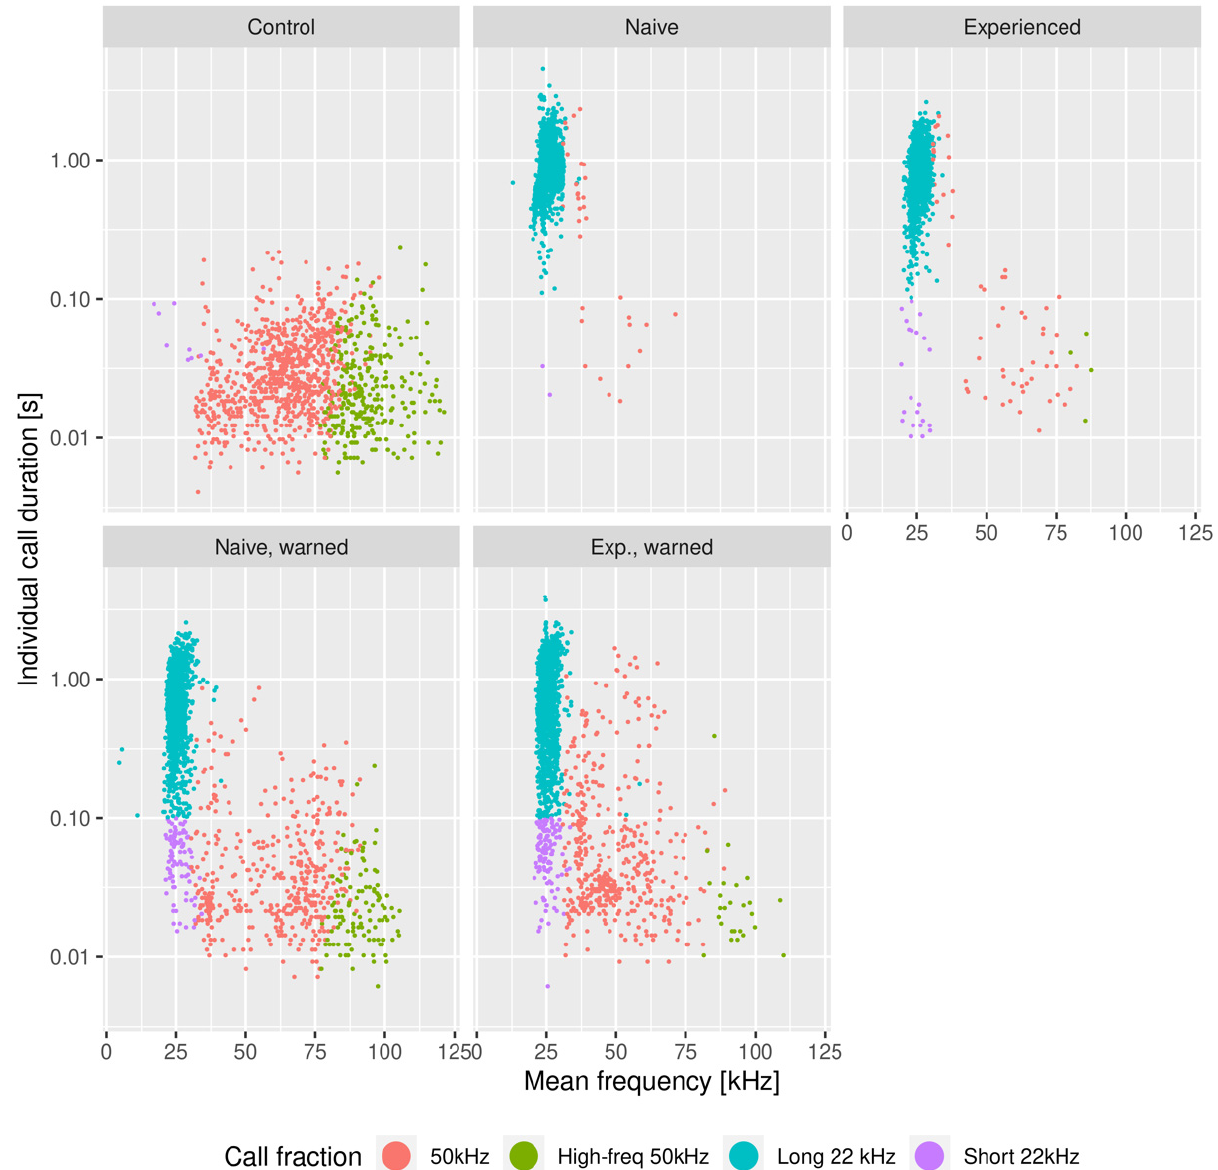
Figure 4. Scatterplot of the basic properties of the recorded USV calls, illustrating their mean frequency and duration. Each panel collects all vocalizations recorded for pairs of a certain class. Each of the presented groups were represented by four pairs of rats (eight animals per group). Color denotes the call fraction. Note that the duration is shown on a logarithmic scale.